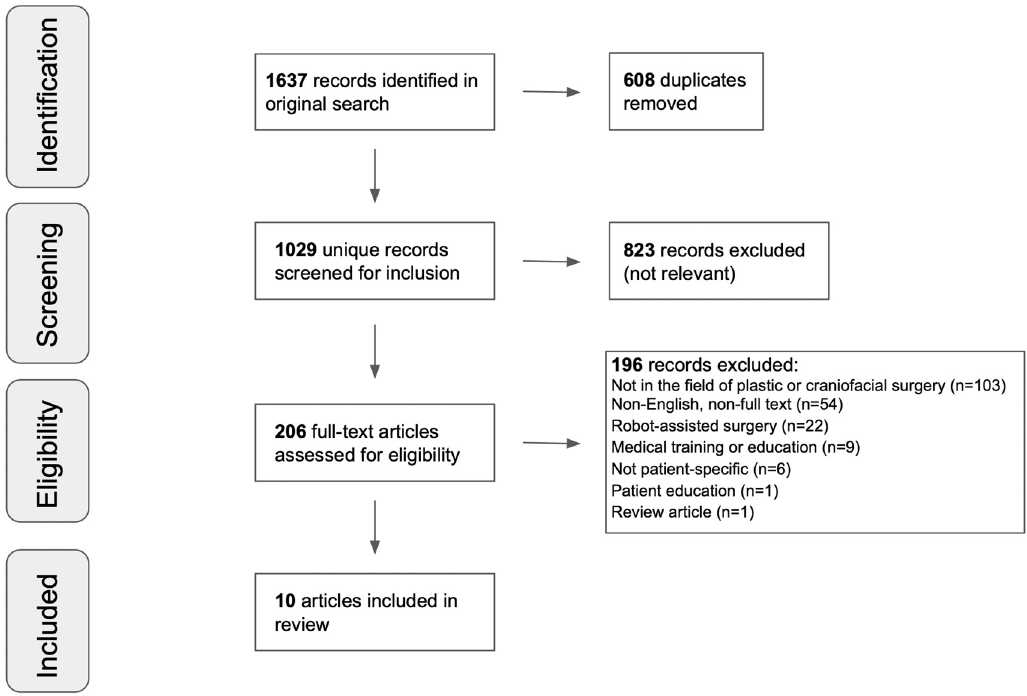
Figure 1. Literature review search results.